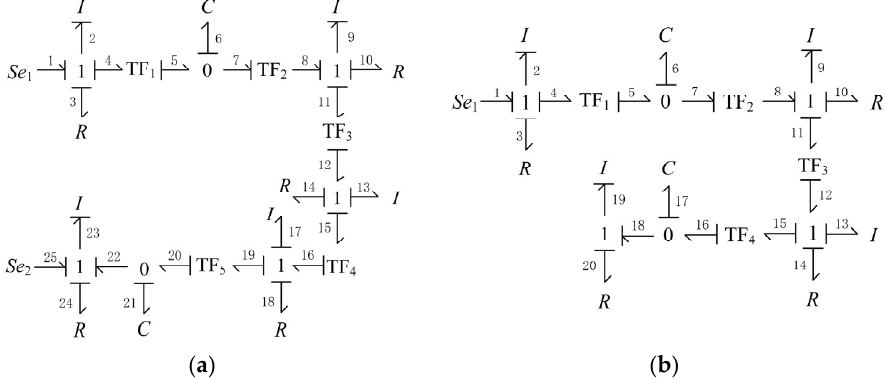
Figure 10. The system bond graph. ( a ) The towing system; ( b ) the capture system.